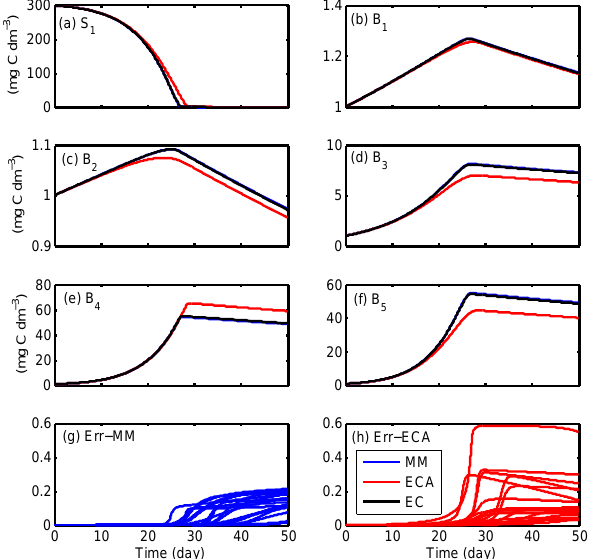
Fig. 8. Comparison of simulations using different substrate kinetics in scenario S1B5: (a–f) are from the simulation that showed the most distinctive differences; (g) and (h) are summaries of the model differences (with respect to the EC results) from the ensemble of 20 random simulations.